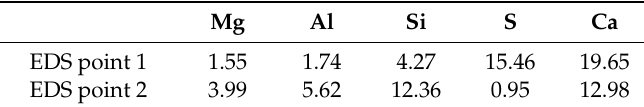
Table 3. Results of EDS analysis (Atomic